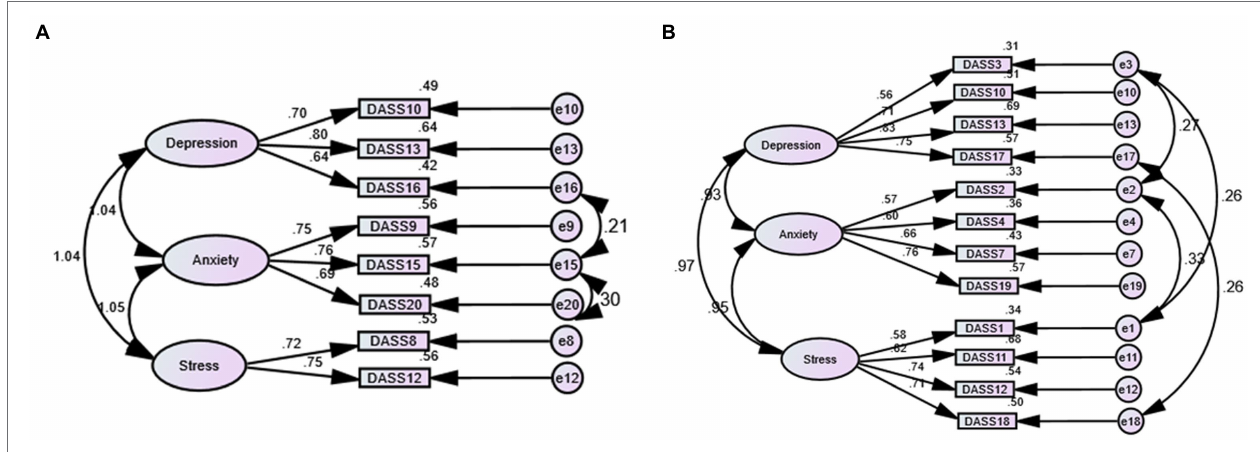
FIGURE 2 | Three-factor structure of the Depression Anxiety stress scale (DASS) 8 (A) and the DASS-12 (B) expressing the best fit in participants from Ghana.